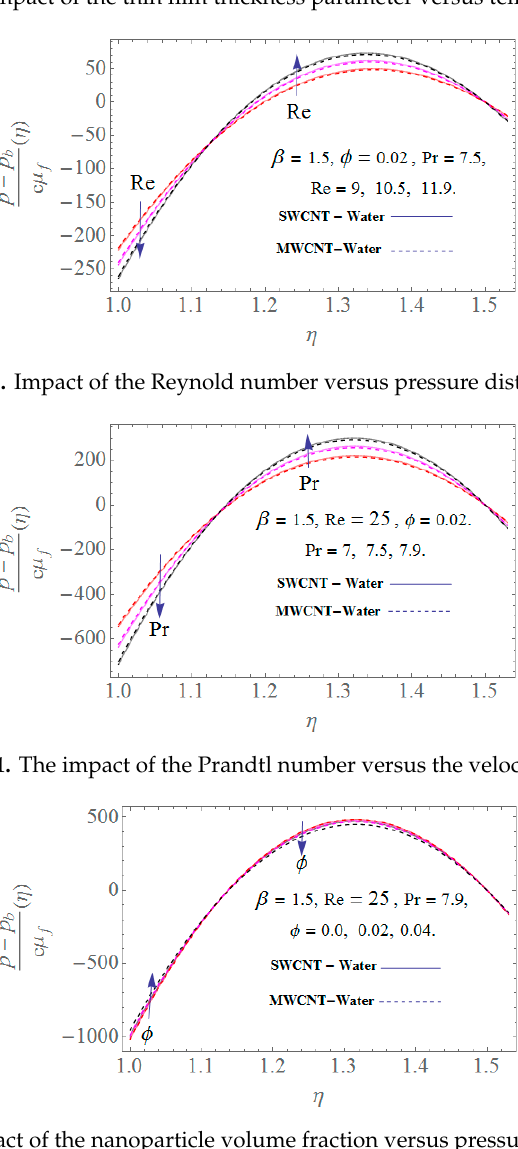
Figure 13. Impact of the thickness parameter versus pressure distribution.